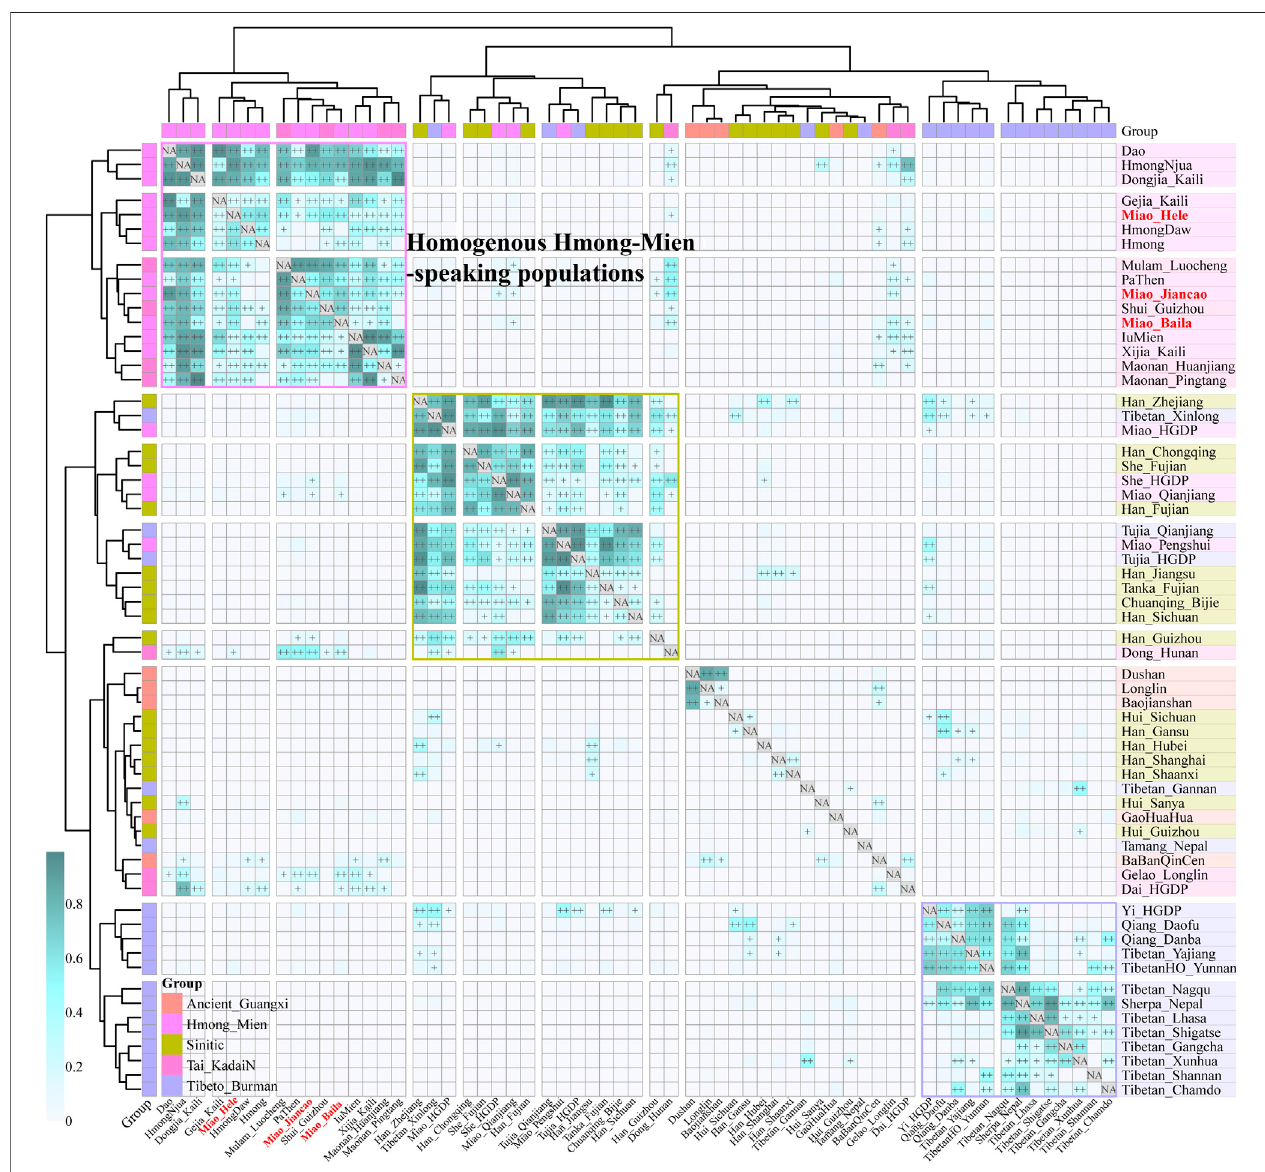
FIGURE 4 | Pairwise qpWave analysis showed the genetic heterogeneity and homogeneity among East Asians. p -values of rank1 tests larger than 0.05 showed the genetic homogeneity among two reference populations, which are marked as “ ++ ” , and p values of rank1 tests larger than 0.01 are marked as “ +. ”